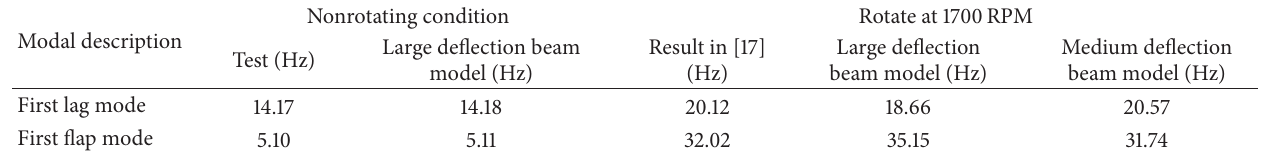
Figure 14: Comparison of shear force in the root between elastic blade and rigid one. Table 2: Modal analysis results for isolated